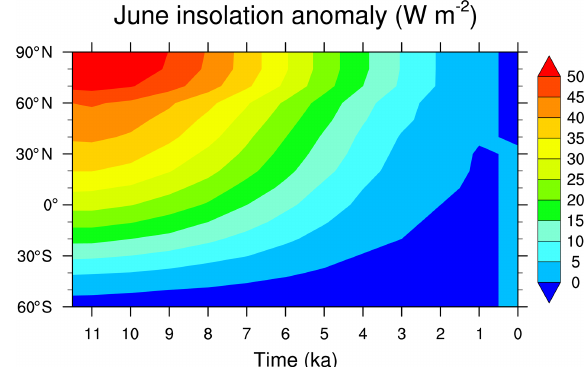
Figure 2. Latitude–time anomalies in the June insolation relative to the average for the last 1000 years, according to Berger